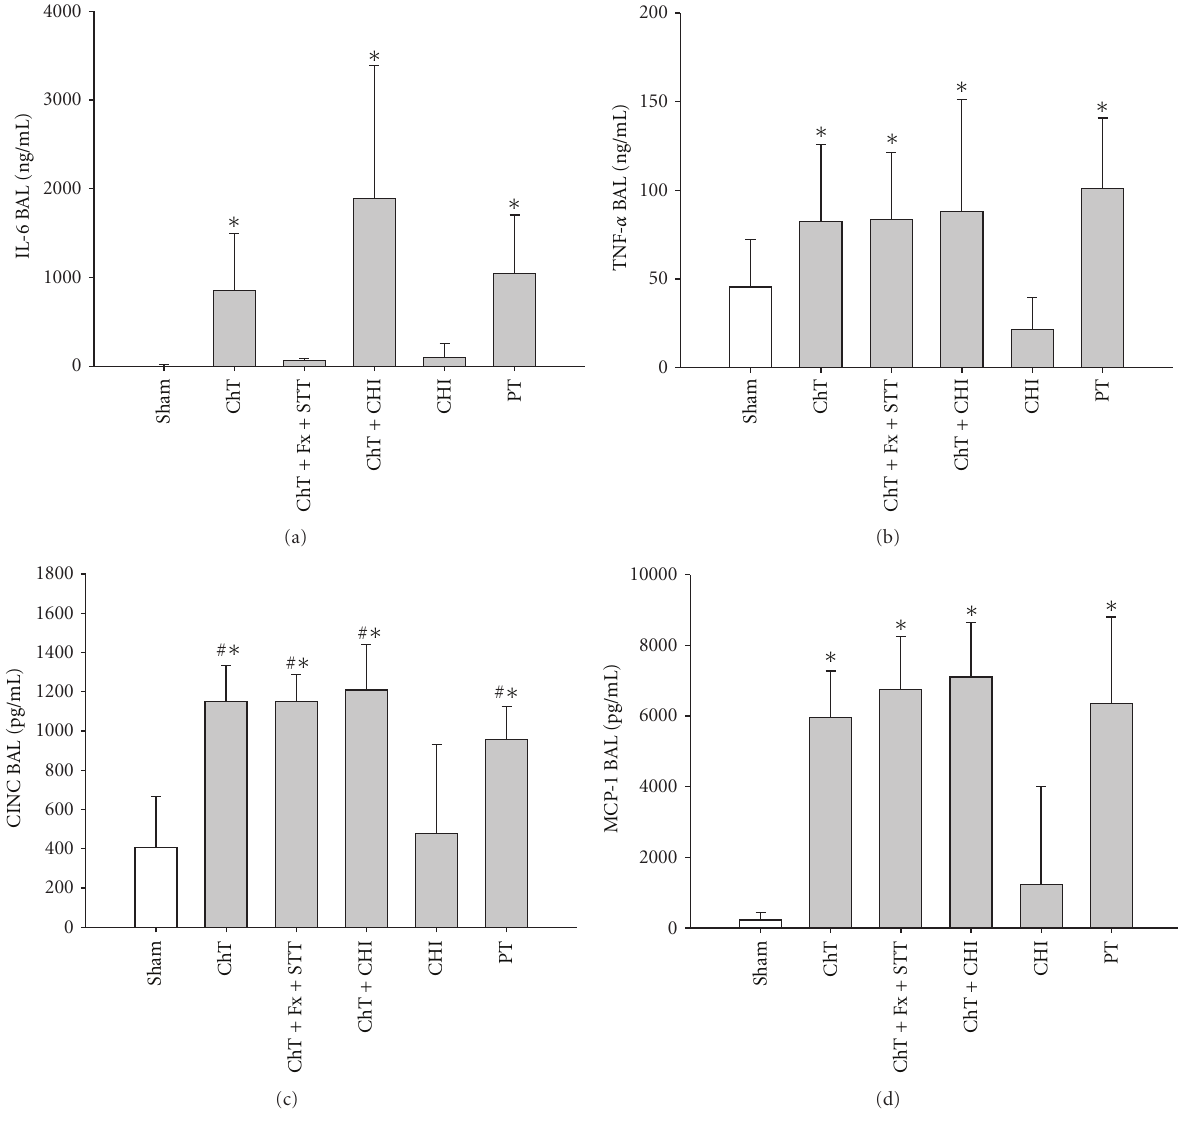
Figure 2: Local inflammatory response following trauma, (a) shows IL-6 (ng/mL) BAL-Fluid levels in Sham-, ChT-, ChT + Fx + STT-, ChT + CHI-, CHI- and PT-rats 4hrs after trauma, (b) TNF- α (ng/mL) BAL-Fluid levels in Sham-, ChT-, ChT + Fx + STT-, ChT + CHI-, CHI- and PT-rats 4hrs post trauma, (c) CINC (pg/mL) BAL-Fluid concentrations in Sham-, ChT-, ChT + Fx + STT-, ChT + CHI-, CHI- and PT-rats 4hrs after trauma and (d) MCP-1 BAL-Fluid levels in Sham-, ChT-, ChT+Fx+STT-, ChT+CHI-, CHI- and PT-rats 4hrs after trauma. All data are presented as mean ± SD. ∗ P < 0 . 05 to Sham; # P < 0 . 05 significant to CHT. n = 6–10